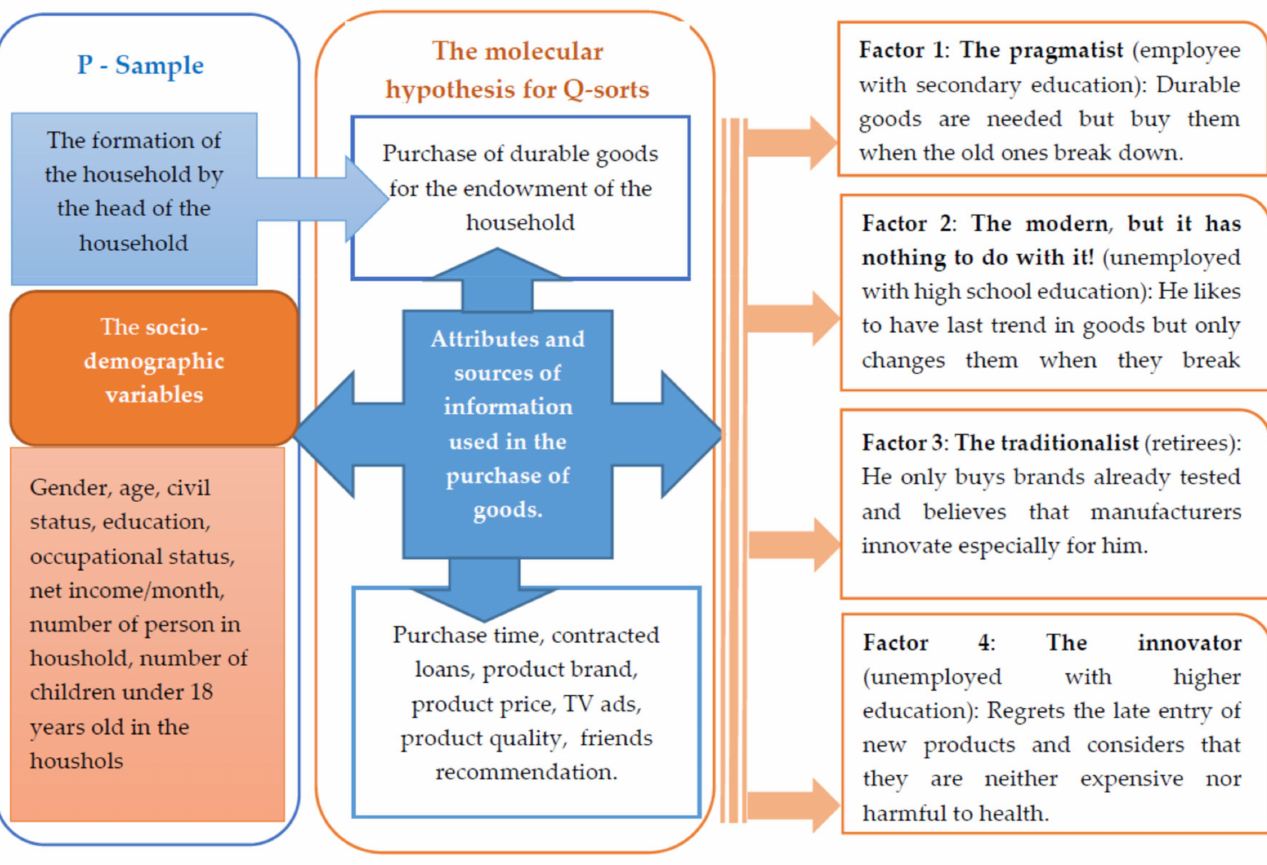
Figure 1. The graphical abstract of the